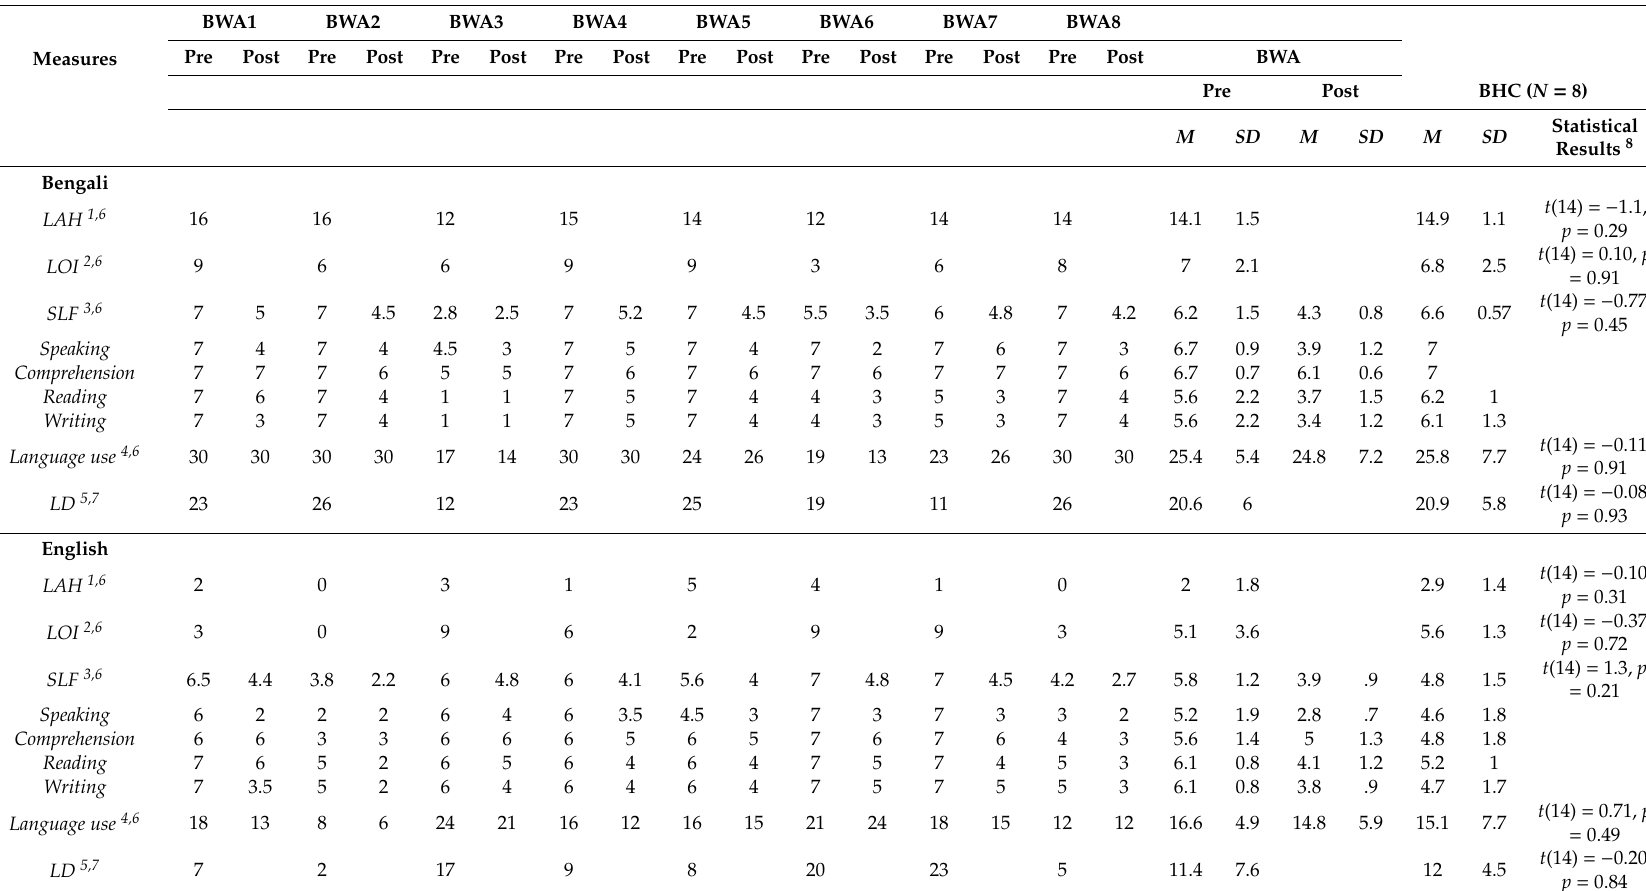
Table 3. Language background questionnaire scores of each BWA, means and standard deviations of BWA and BHC groups, and the statistical results comparing the